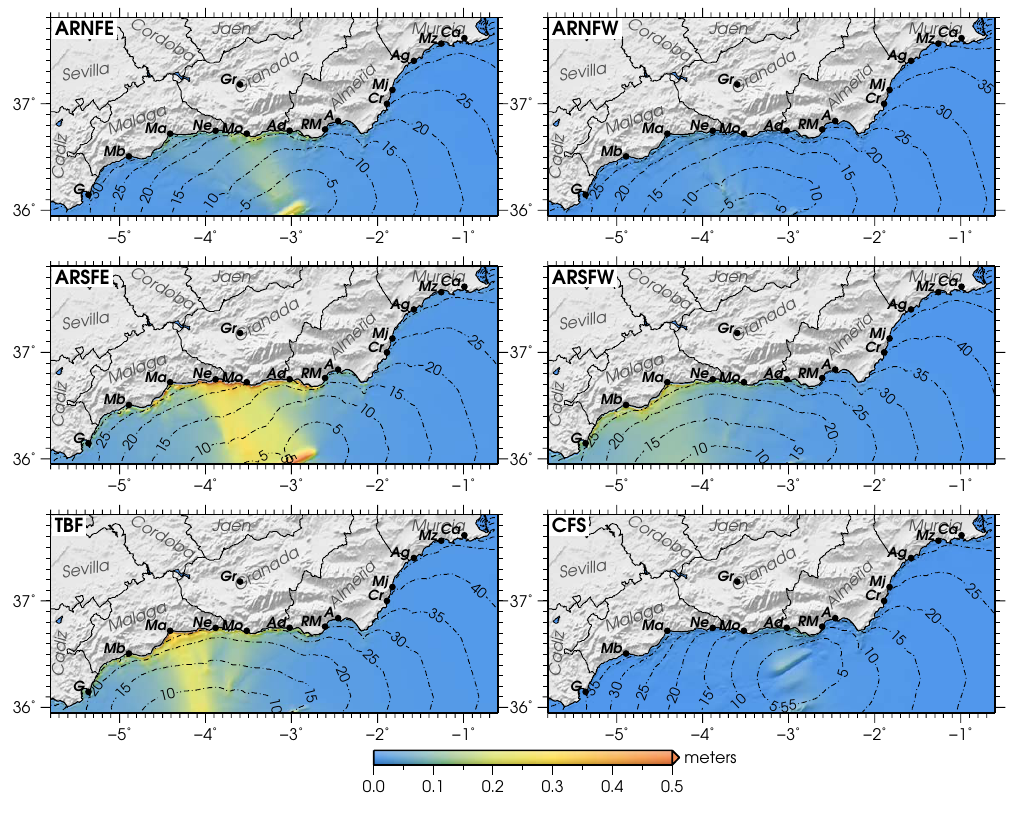
Fig. 4. Maximum wave elevation maps and estimated tsunami travel times in the Alboran Sea. The shading represents the wave elevation value as shown in the colour scale at the bottom. The contours show the tsunami travel time in 5min steps from the source. ARNFE: Alboran Ridge Northern Fault East segment; ARNFW: Alboran Ridge Northern Fault West segment; ARSFE: Alboran Ridge Southern Fault East segment; ARSFW: Alboran Ridge Southern Fault West segment; TBF: Tofi˜no Bank Fault; CFS: Carboneras Fault Southern segment. Black dots show the location of relevant populations: G, Gibraltar; Mb, Marbella; Ma, Malaga; Gr, Granada; A, Almeria; Ca, Cartagena; Mo, Motril; Ad, Adra; RM, Roquetas de Mar; Cr, Carboneras; Mj, Mojacar; Ag, Aguilas; Mz, Mazarron; Ne,